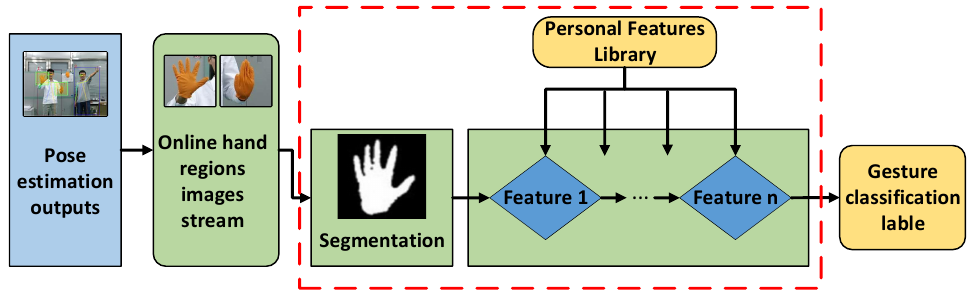
Figure 12. Gesture recognition